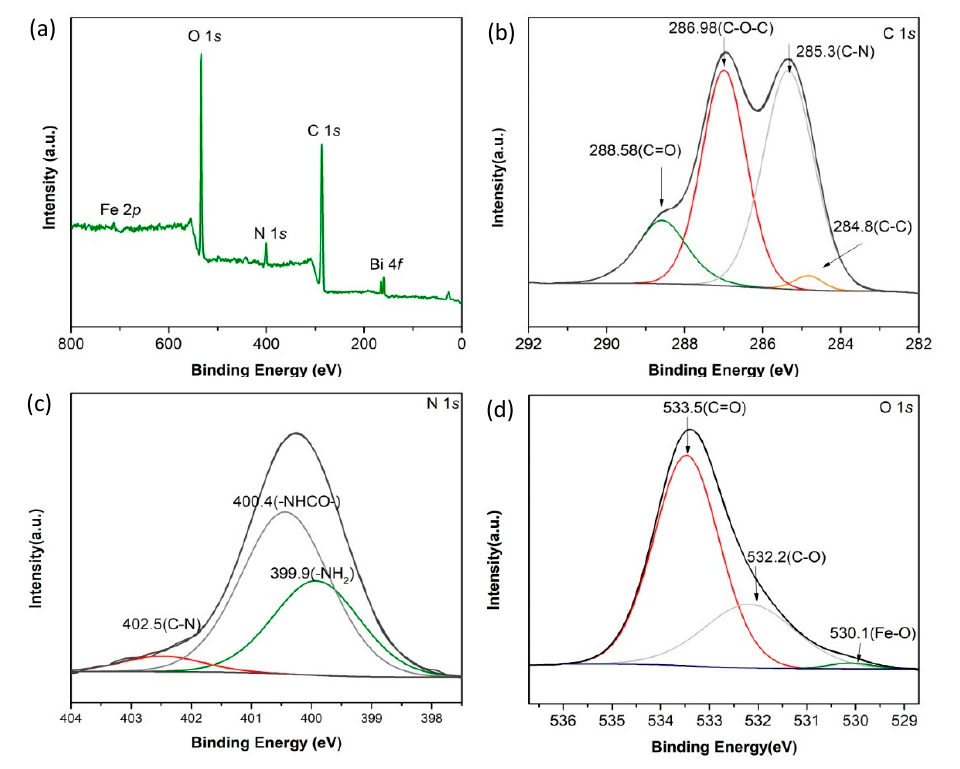
Figure 2. ( a ) XPS survey scan spectrum, ( b ) C 1s, ( c ) N 1s, and ( d ) O 1s XPS spectra of CKB.